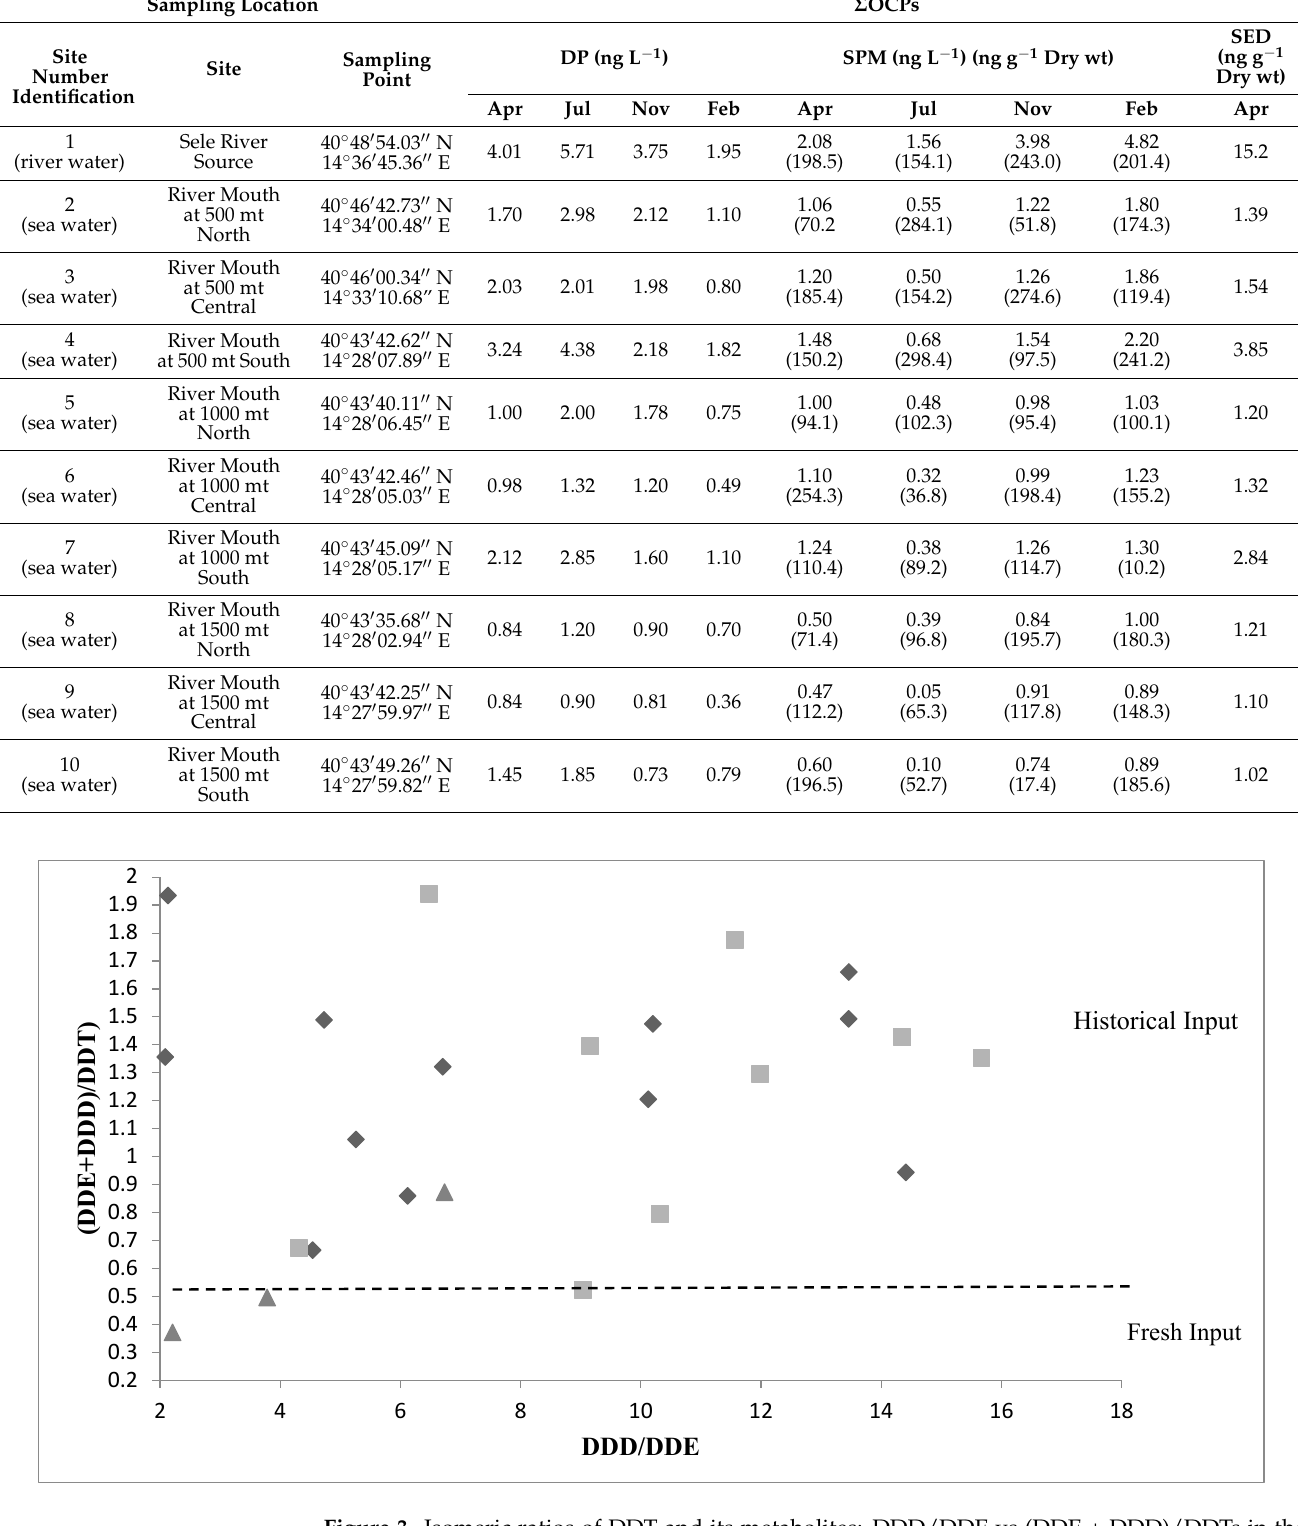
Figure 3. Isomeric ratios of DDT and its metabolites: DDD/DDE vs (DDE + DDD)/DDTs in the samples from Sele River. In the Figure the dotted line represents the point (0.5) where the fresh input becomes historical input. (cid:117) DP samples. (cid:4) SPM samples. (cid:78) SED